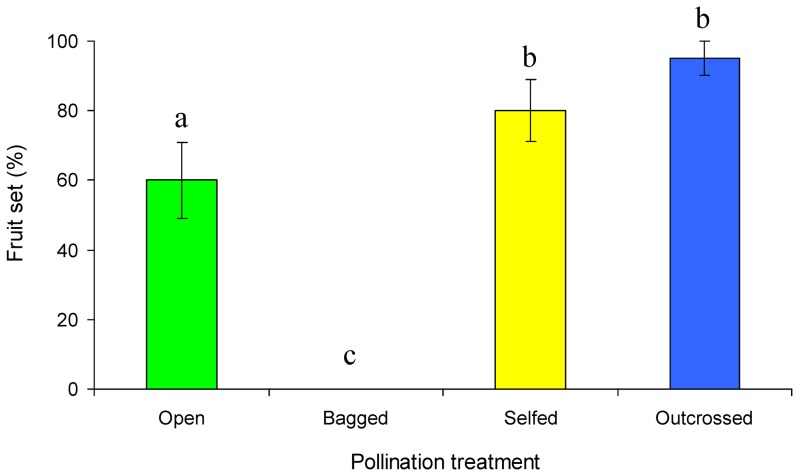
Breeding system of Parnassia palustris.Different letters above the bars indicate statistically significant difference at P<0.05 (one-way ANOVA, N = 20). Open, open-pollination; Bagged, bagged without any treatment; Selfed, hand self-pollination (hand-pollinated by the self pollen from the last-dehisced anther); Outcrossed, hand cross-pollination.